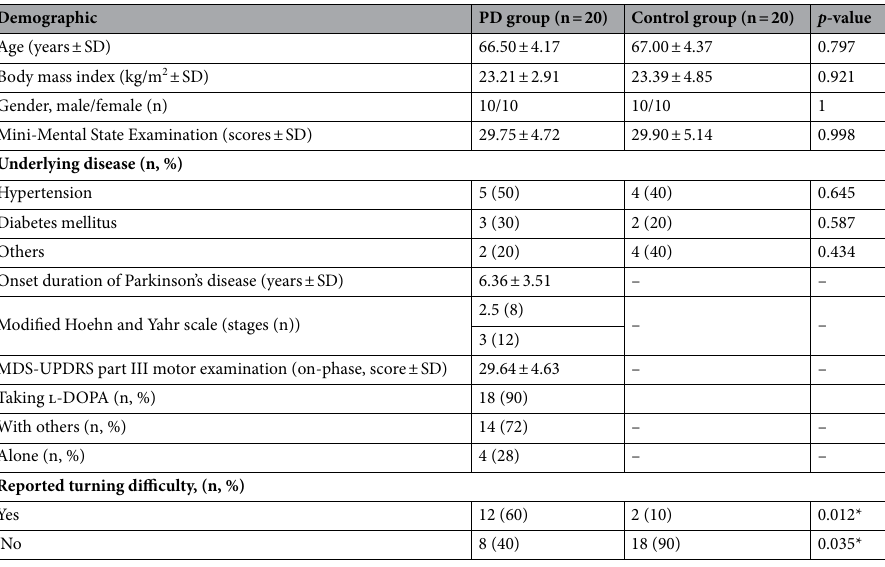
Table 1. Demographic data for the individuals with Parkinson’s disease (PD) (n = 20) and the healthy older adult group (n = 20). MDS-UPDRS Movement Disorder Society Unified Parkinson’s Disease Rating Scale, SD standard deviation. *Significant difference ( p < 0.05) by independent